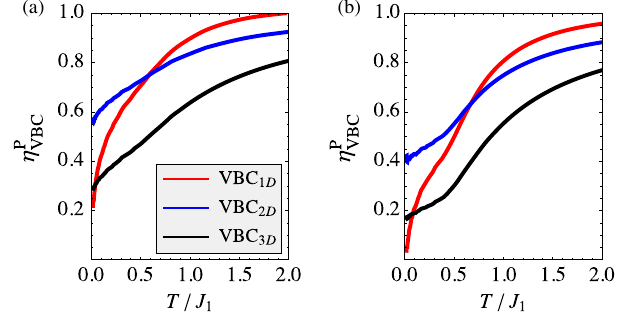
FIG. 9. The RG flows of the dimer response functions η P [Eq. (15)] of different valence-bond crystals for (a) S ¼ 1 = 2 and (b) S ¼ 1 isotropic nearest-neighbor Heisenberg antiferro- magnets.